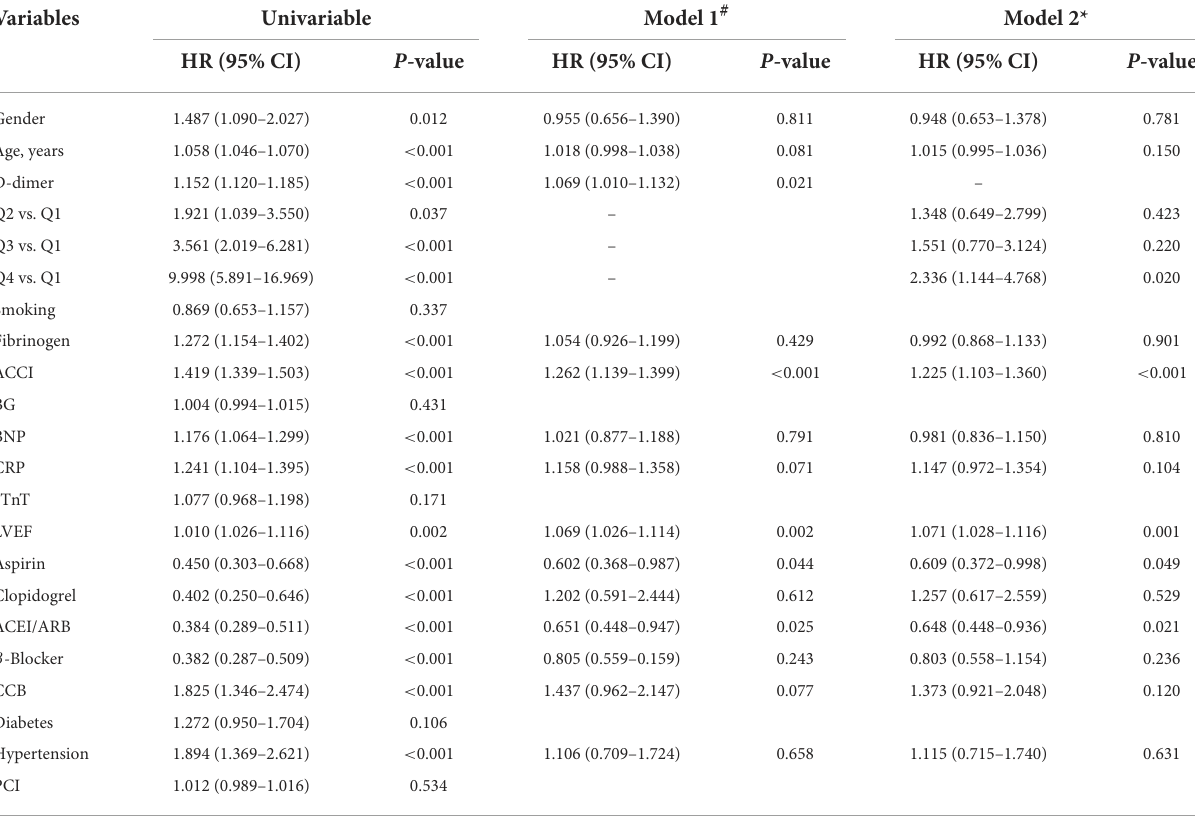
TABLE 4 The univariate and multivariate Cox regression analyses of MACEs in patients with NSTEMI.